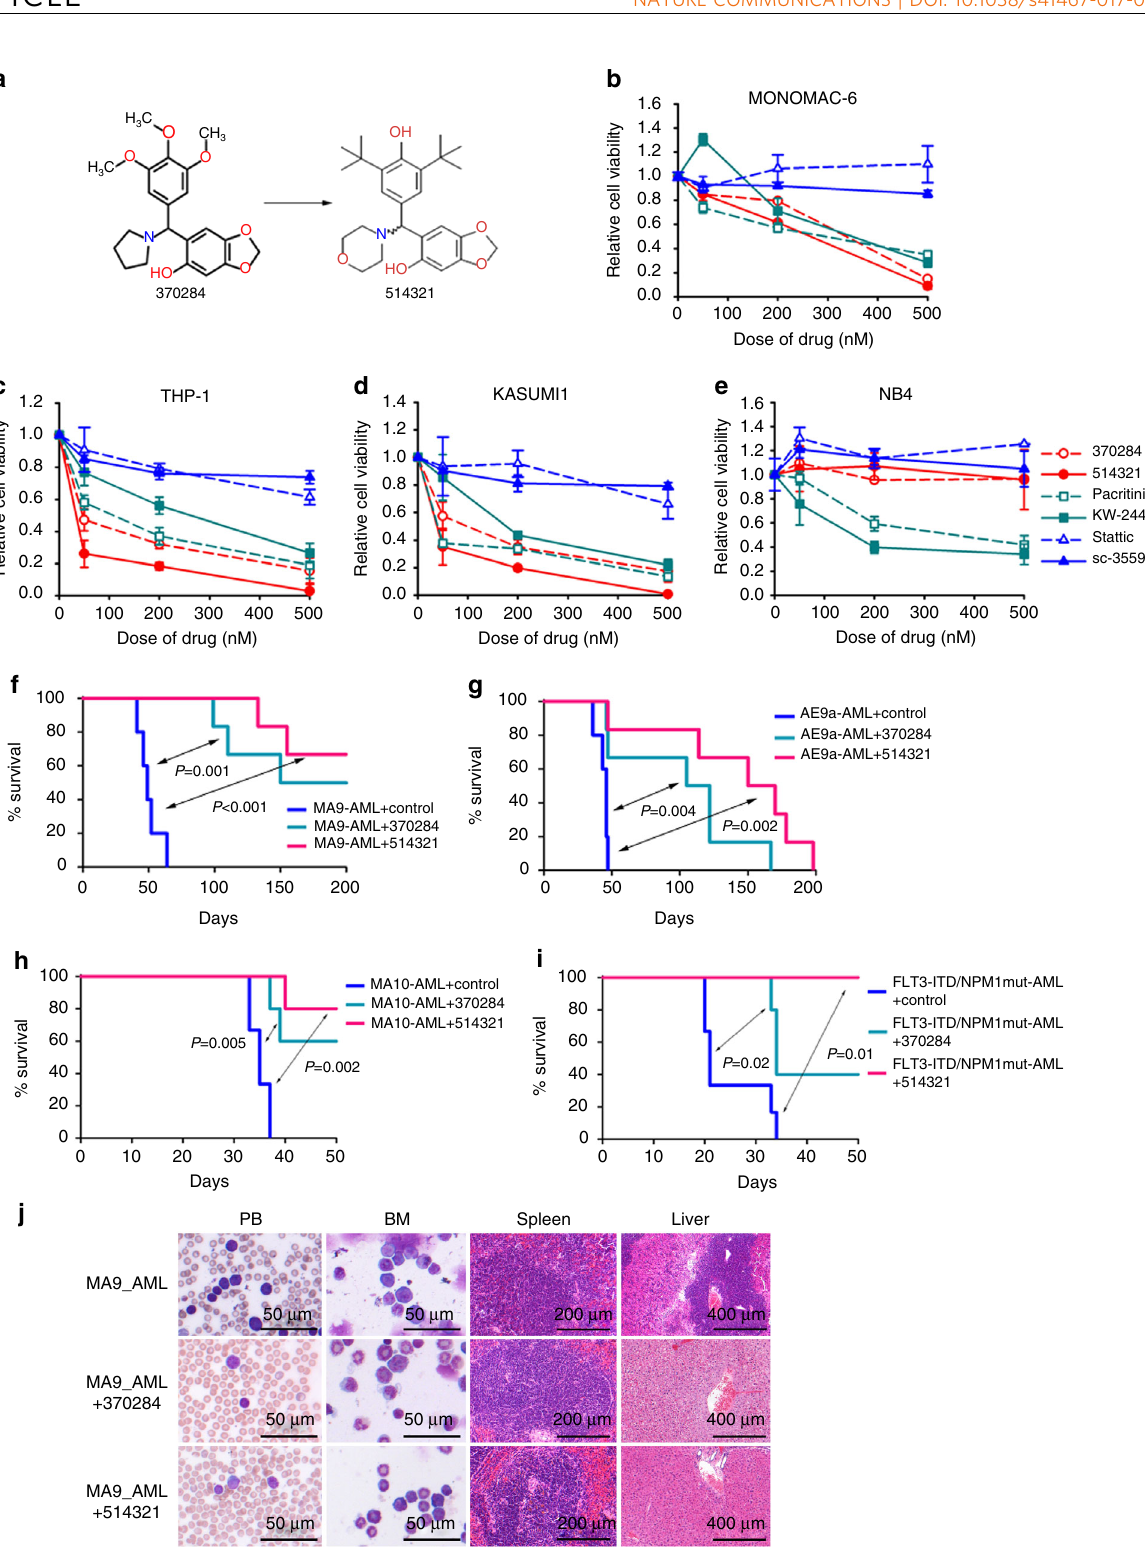
Fig. 4 Effects of UC-514321 in treating AMLs. a Structures of NSC-370284 and UC-514321. b – e Effects of NSC-370284, UC-514321, and other JAK/STAT pathway inhibitors, i.e., Pacritinib, KW-2449, Stattic and sc-355979, on the viability of AML cell lines MONOMAC-6 ( b ), THP-1 ( c ), KASUMI1 ( d ), and NB4 ( e ). Cells were treated with drugs at indicated doses. Cell viability was detected by MTS 48 h post treatment. Error bar indicates SD of triplicate experiments. f – j Enhanced therapeutic effect of UC-514321, relative to NSC-370284, in treating TET1 -high AMLs in vivo. Secondary BMT recipient mice were transplanted with primary leukemic BM cells with MLL-AF9 ( f ), AML-ETO9a ( g ), MLL-AF10 ( h ), or FLT3 -ITD/ NPM1 mut ( i ). Upon the onset of leukemia, the recipient mice were treated with DMSO (control) ( n = 5 or 6), 2.5 mg/kg NSC-370284 ( n = 5 or 6), or UC-514321 ( n = 5 or 6), i.p., once per day, for 10 days. Kaplan – Meier curves are shown. The P values were determined by log-rank test. j Wright – Giemsa staining of mouse PB and BM, or H&E staining of mouse spleen and liver of MLL-AF9 AML secondary BMT recipients with or without drug